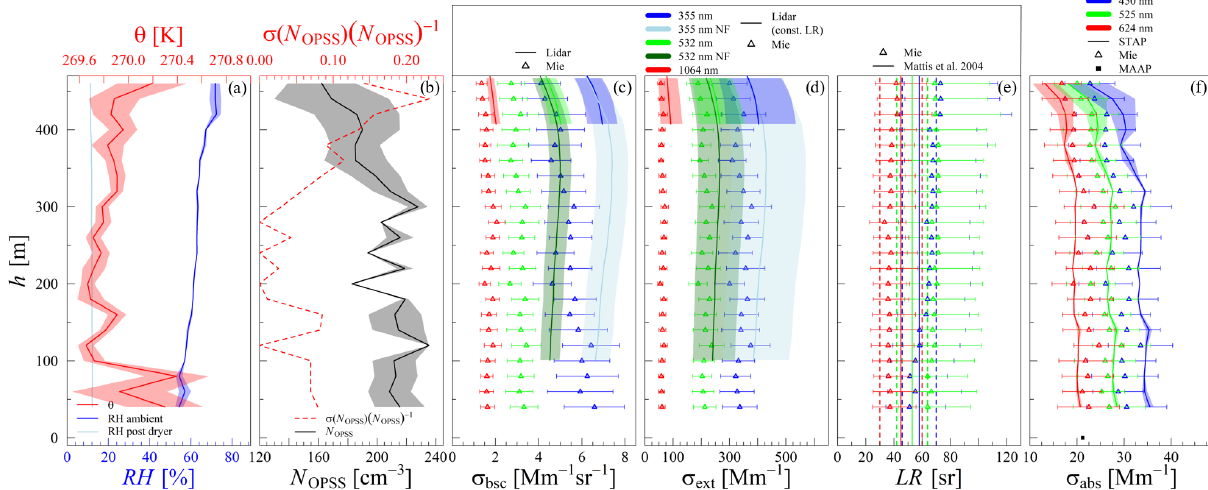
Figure 7. (a) The 20m layer averages of the ambient and post-dryer RH and T . (b) The aerosol particle number concentration measured by the OPSS ( N OPSS ) and the ratio of the standard deviation of the mean and the mean itself (solid black and red dashed line) are shown. Shaded areas around T , RH, and N OPSS represent the standard deviation of the mean in the layer. Panels (c) , (d) , and (f) display the aerosol particle light backscattering ( σ bsc (λ)) , extinction ( σ ext (λ)) , and absorption coefficients ( σ abs (λ)) . Mean values are calculated for the period 11:20–11:58UTC on 9 February 2017. Shaded areas in panel (f) represent the standard deviation of the mean. Shaded areas around the lidar-based coefficients indicate the assumed 10% uncertainty of σ bsc (λ) and the range of possible σ ext (λ) , following the given range of Mattis et al. (2004). Panel (e) displays the LR( λ) derived with the Mie model (dots with a range bar from min to max), and the reference of Mattis et al. (2004) with its respective uncertainty range is displayed with dashed lines. Uncertainty bars around the Mie-based coefficients cover the range from − 3 to + 3 times standard deviation. Uncertainty around the LR( λ) is minimum and maximum LR( λ) resulting from calculations with the 3 times standard deviation from the σ bsc (λ) and σ ext (λ) .